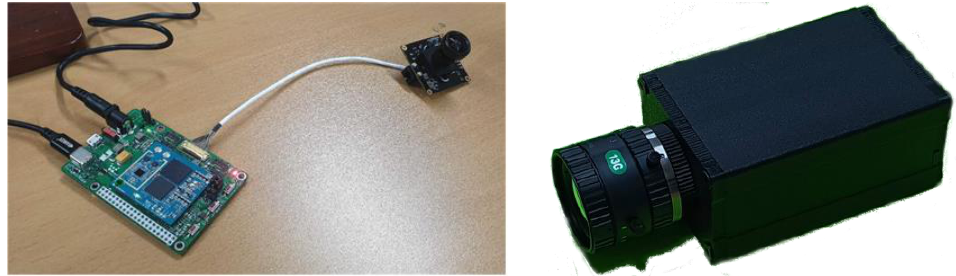
Figure 12. Intelligent camera equipped with Qualcomm QCS605.